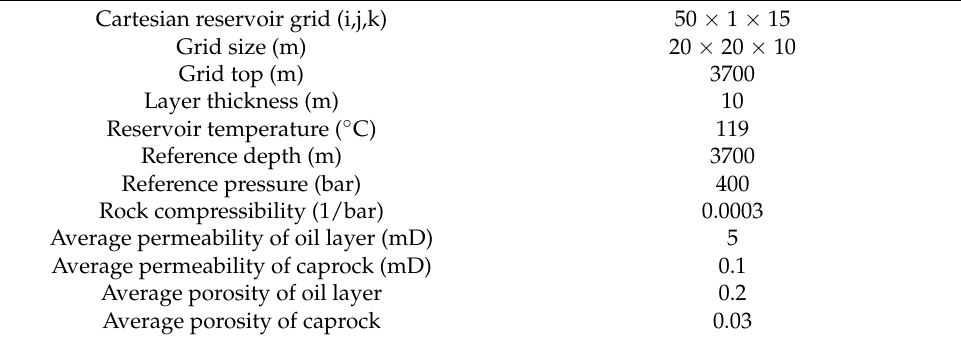
Table 1. Reservoir model parameters.